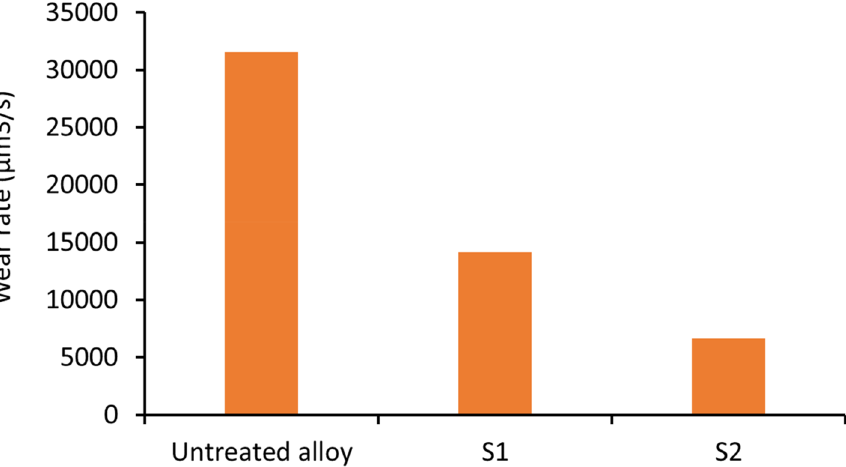
Figure 10. Wear rate of the samples tested. All samples were tested for thirty minutes S1-40 nm Al 2 O 3 -250 nm TiO 2 and S2-40 nm-Al 2 O 3 -30 nm TiO 2